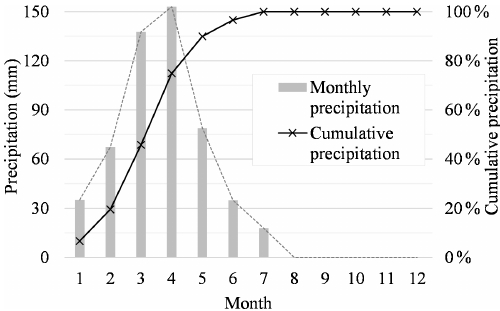
Figure 2. Monthly precipitation (median) and cumulative precip- itation at the Madalena representative basin (MRB) from 1958 to